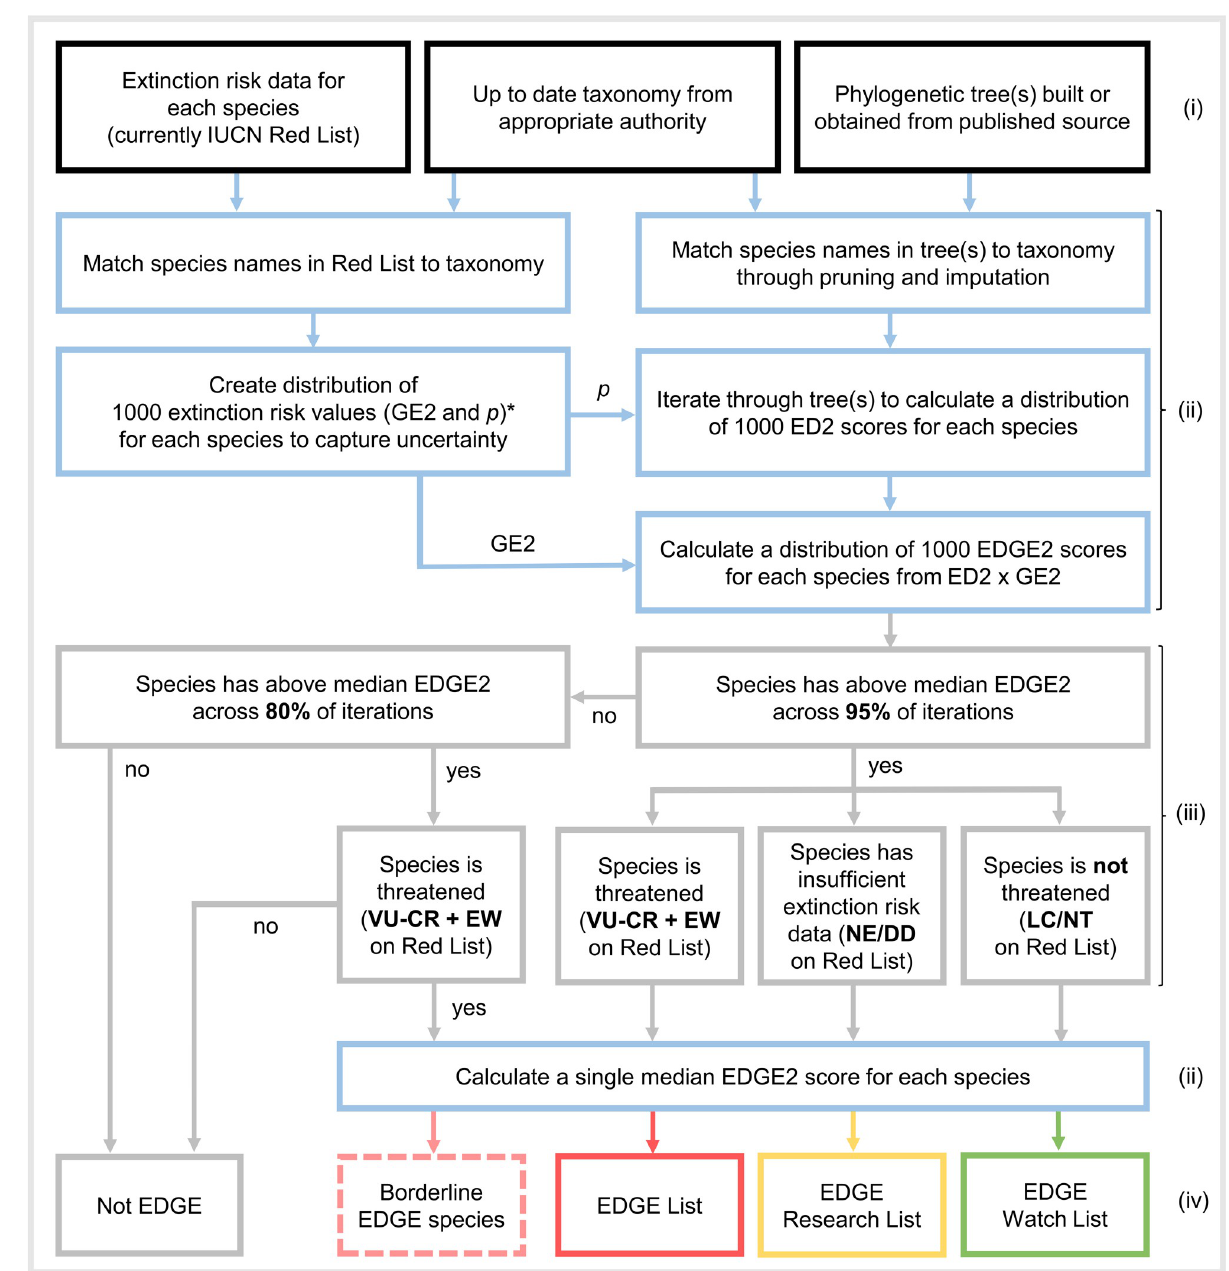
Fig 2. The EDGE2 protocol. The protocol, from data input to final output, for producing a comprehensive EDGE2 prioritisation for a set of species. Stages from top (beginning) to bottom (end): required data (i–input data); data processing stages (ii–blue); selection criteria to be applied (iii–grey); and outputs (iv). � p and GE2 are assigned equivalent values in EDGE2 but may differ in future work given increased understanding of extinction risk, the likely effects of future conservation work, and its distribution across the Tree of Life (see S1 Text). The single median EDGE2 score for each species, based on the values of p and GE2 used in this study, can be compared across studies and clades and should not be sensitive to the size of clade used in the study. In contrast, membership of the EDGE2 list and other related lists is sensitive to the other species included in the study. For example, an EDGE2 mammal should have the same EDGE2 score in a mammal-level study and a tetrapod-level study but might not qualify for the EDGE2 list for all tetrapods if the nonmammalian tetrapods have higher EDGE2 scores, thus reducing the confidence that its EDGE2 score is above the median of the larger